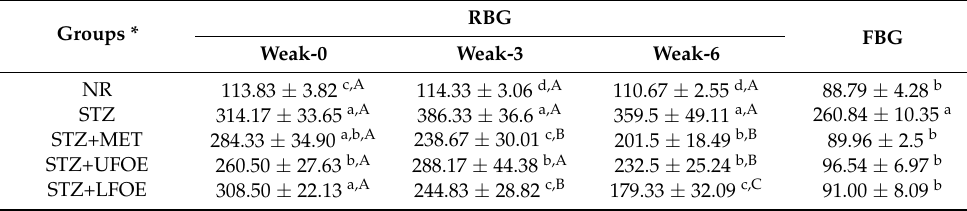
Table 4. Effect of orally administrated fermented oat extract on RBG and FBG (mg dL − 1 ) in Streptozotocin-induced diabetes in rats (mean ± SE), n =